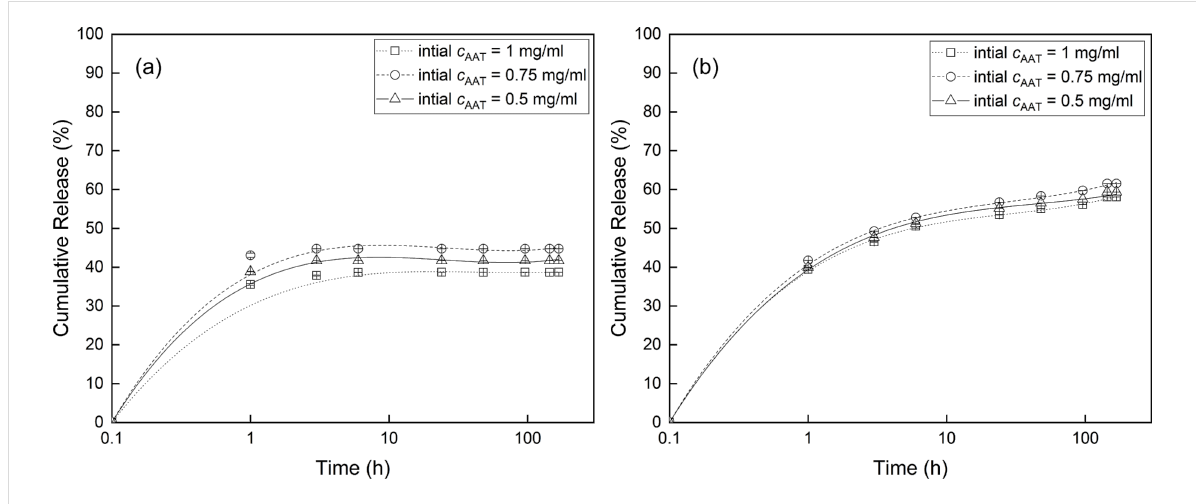
Figure 5: Release of 125 I-radiolabeled α -1-antitrypsin from PHEG-Tyr (a) and N α -Lys-NG (b) nanogels at initial 125 I-radiolabeled α -1-antitrypsin con- centrations of 1 mg/mL (squares), 0.75 mg/mL (circles), and 0.5 mg/mL (triangles). The lines are to guide the eye.